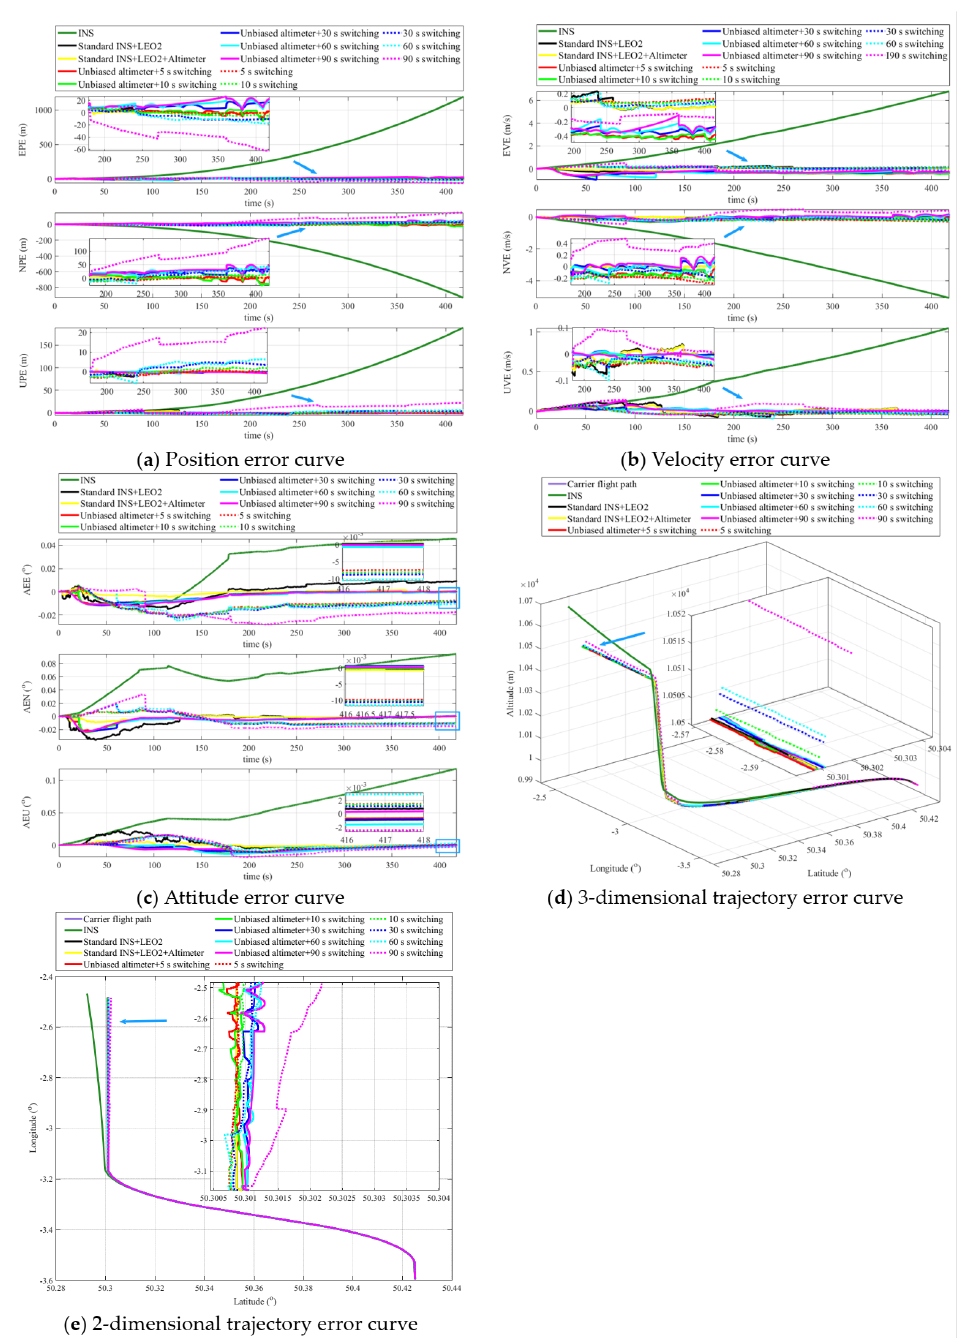
Figure 6. The experimental results of the INS + LEO2 + unbiased altimeter and no altimeter scenarios under adjacent